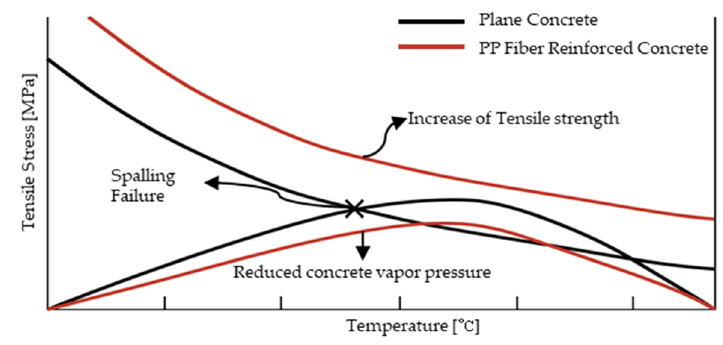
Figure 1. Preventing explosions by applying PP fiber [13].